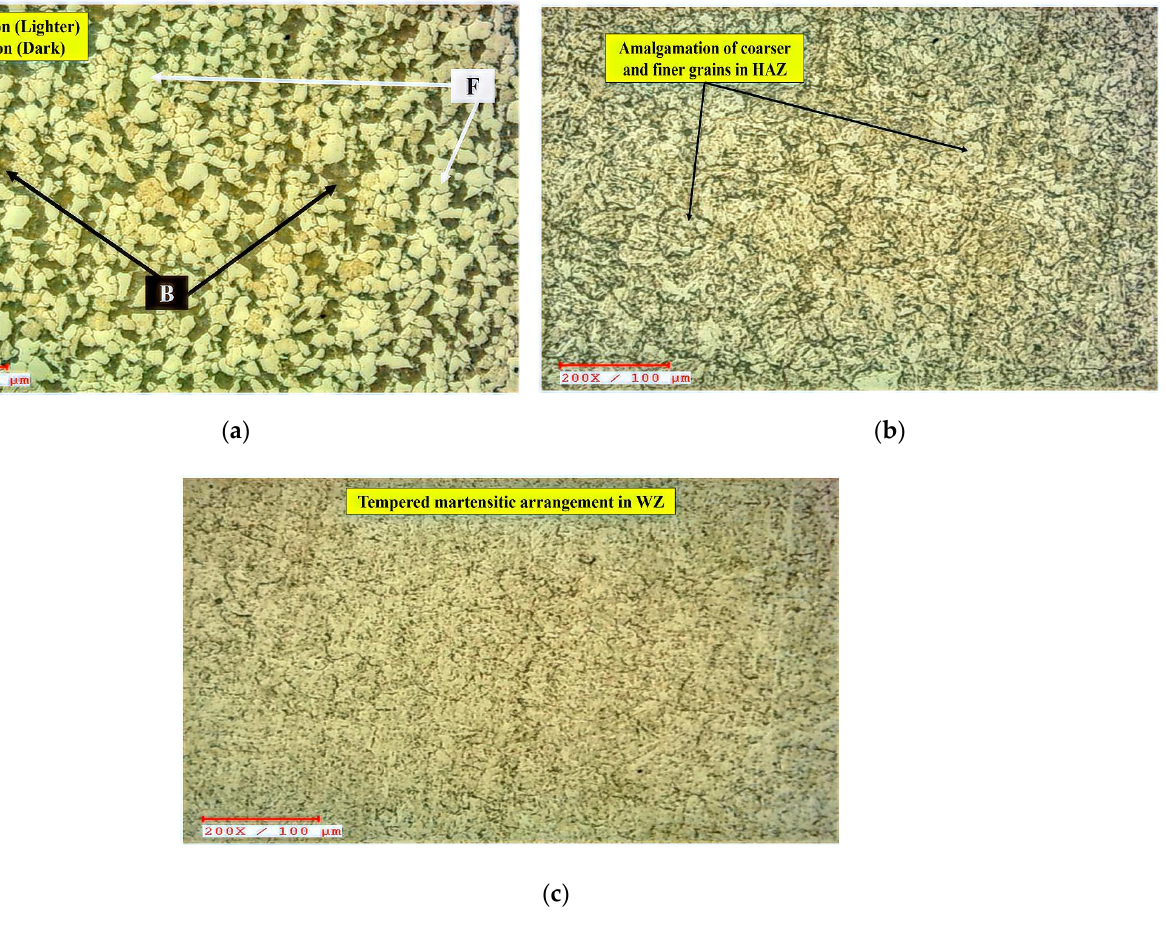
Figure 8. Surface morphology of the ASTM A387-Gr.11-Cl.2 weldments in various regions after heat treatment. ( a ) BM. ( b ) HAZ. ( c ) WZ. treatment. ( a ) BM. ( b ) HAZ. ( c )